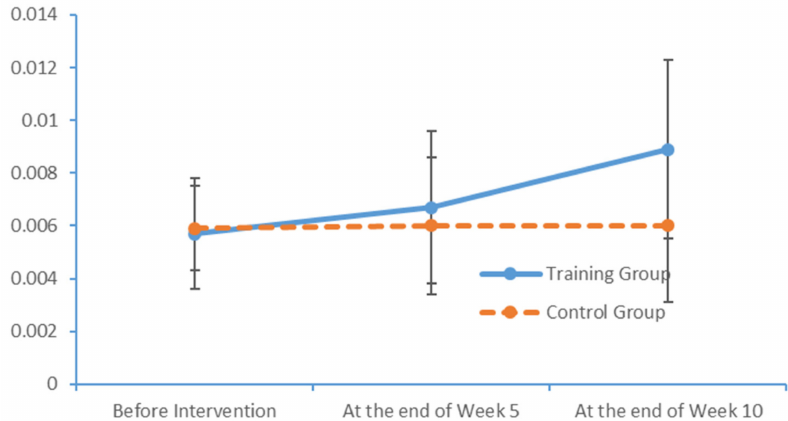
Figure 12. Changes in the power values of the alpha_region_central wavebands measured in the two subject groups at several time